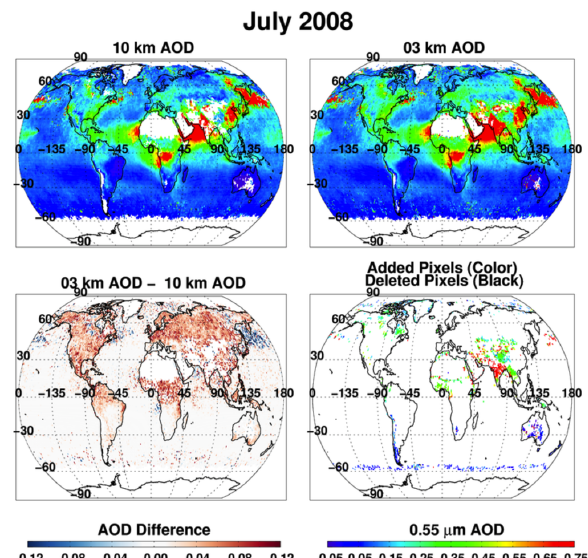
Fig. 11. Spatially distributed monthly mean AOD for July 2008 for 10km, upper left; 3km upper right; the difference (3–10km) and the AOD of grid squares added to the 10km map by the 3km re- trieval.